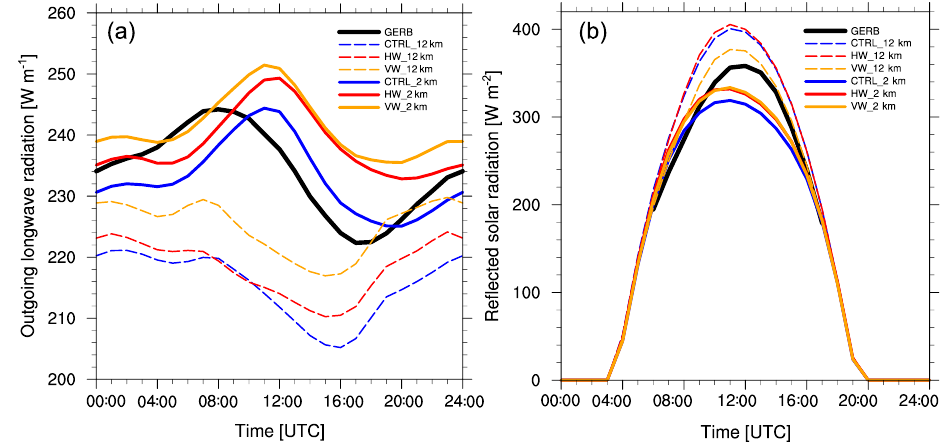
Figure 7. Spatially and temporally averaged diurnal cycles of top-of-the-atmosphere (a) outgoing longwave radiation (OLR) and (b) reflected solar radiation (RSR) for observations from GERB and six simulations for 3–13 June 2007. Observations are indicated in black, control runs in blue, HW runs in red, VW runs in orange, 12km runs with dashed lines, and 2km runs as well as observations with solid